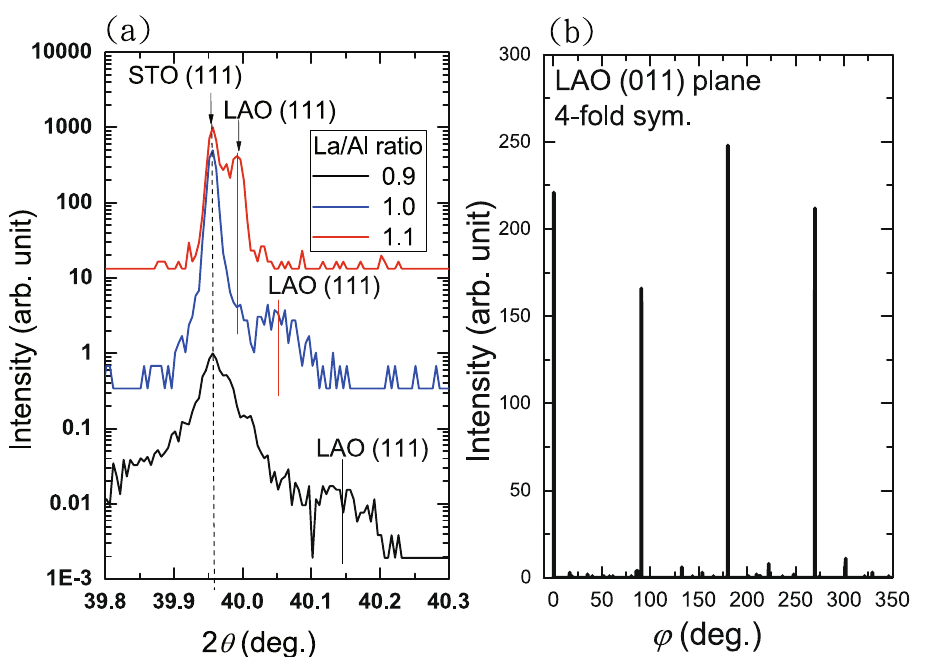
Figure 3. ( a ) θ -2 θ XRD scans of the 100-uc LAO films with different La/Al ratios. ( b ) ϕ -scan of a 100-uc thin LAO film shows a fourfold